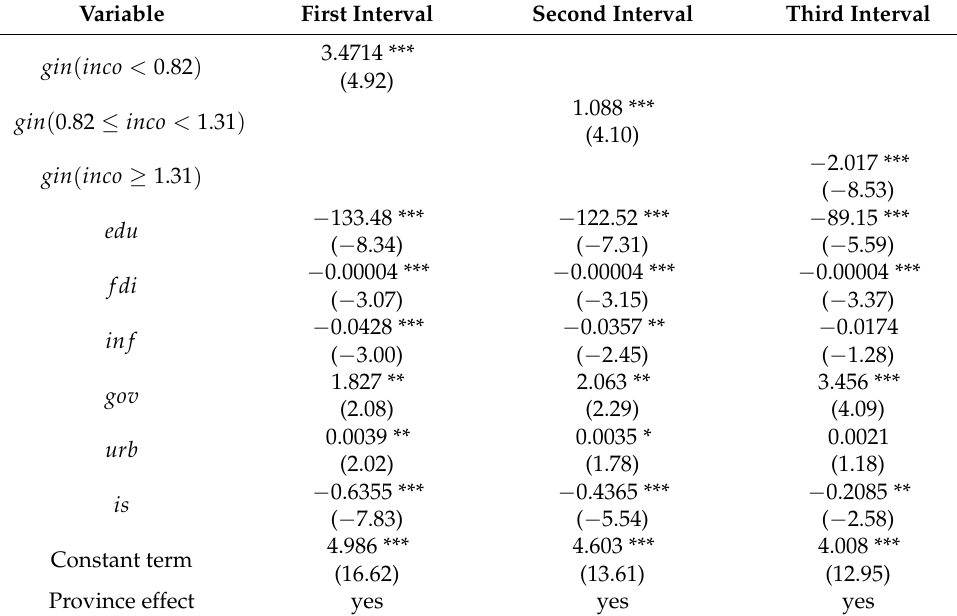
Figure 3. Threshold estimates and confidence intervals. Table 6. Threshold regression